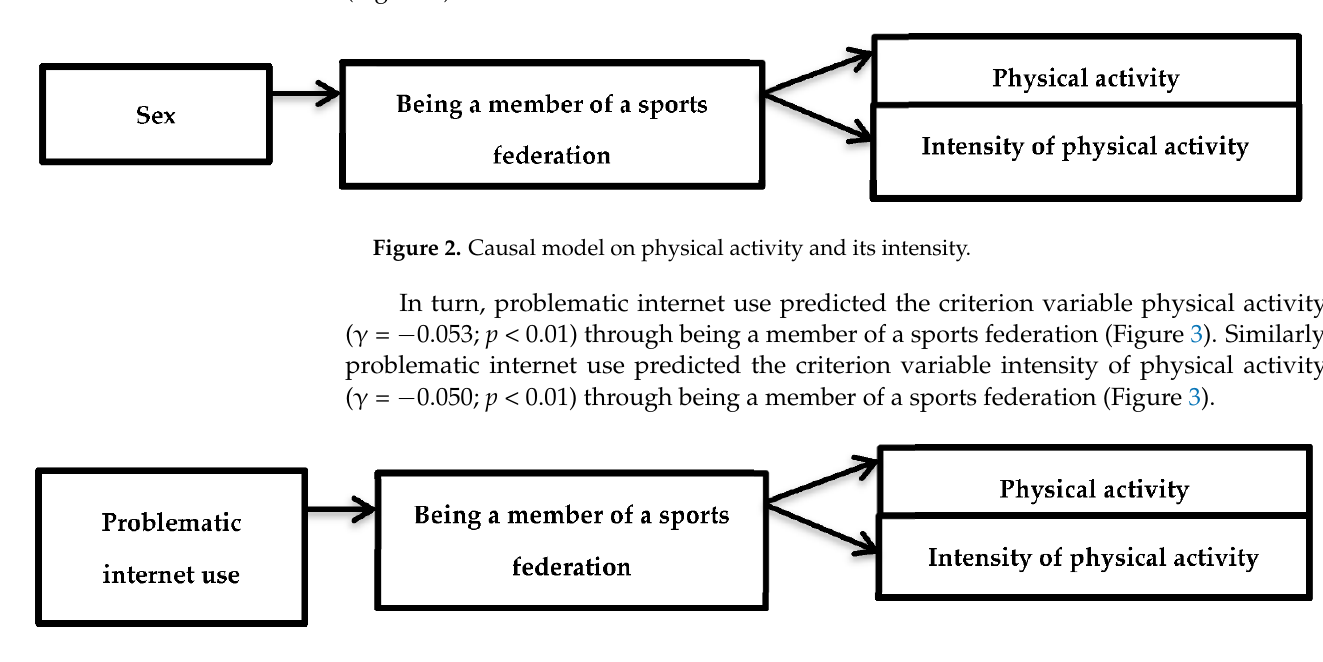
Figure 3. Causal model on physical activity and its